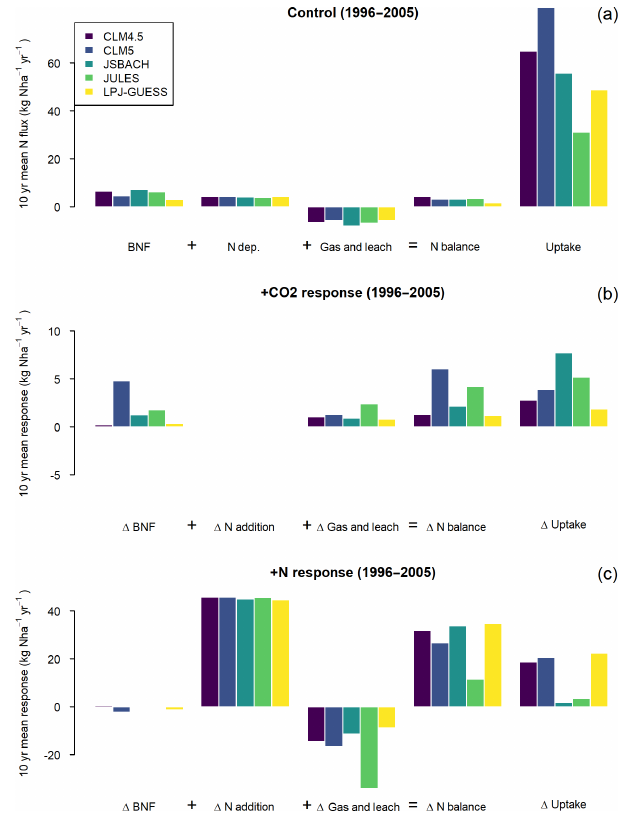
Figure 6. Global averaged 1996–2005 biological nitrogen fixation (BNF), N deposition, N loss via gases and leaching, the balance of those three inputs/losses, and the plant N uptake of the models. The top panel represents the Control scenario, and the second and third panels represent the response to + CO 2 and + N perturbations (see Methods section). Note that the y -axis scale is 4 × smaller for + CO + N response. All changes are 2 response than the Control or relative to a nominal N pool in the terrestrial biosphere. Gas and Leaching loss is therefore shown as a negative (a loss from that N pool) in the Control. In the + CO 2 and + N responses, a positive change in “Gas and leach” indicates less losses than in the Control scenario, and a negative change losses more than the